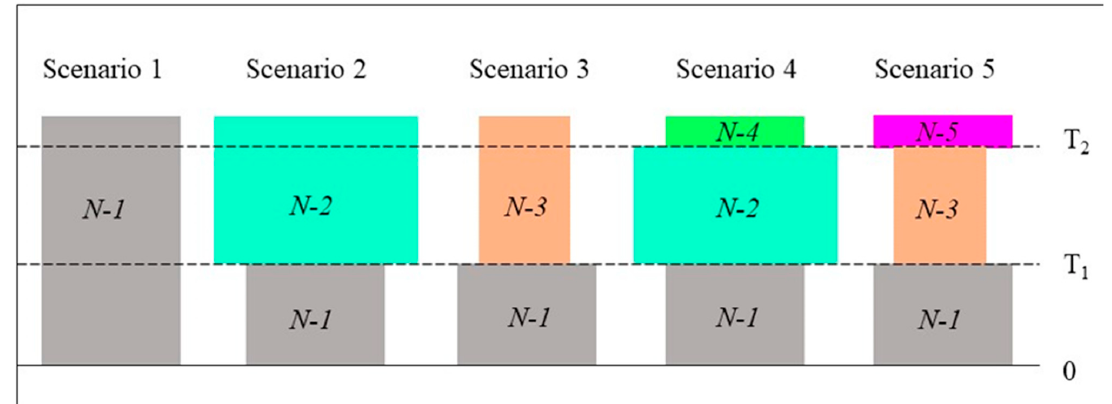
Figure 2. Five historical demographic scenarios for Campylorhynchus yucatanicus using DIYABC RF. Parameter conditions were as follows: t2 > t1; N2 > N1; N3 < N1; N4 < N2; N5 > N3.